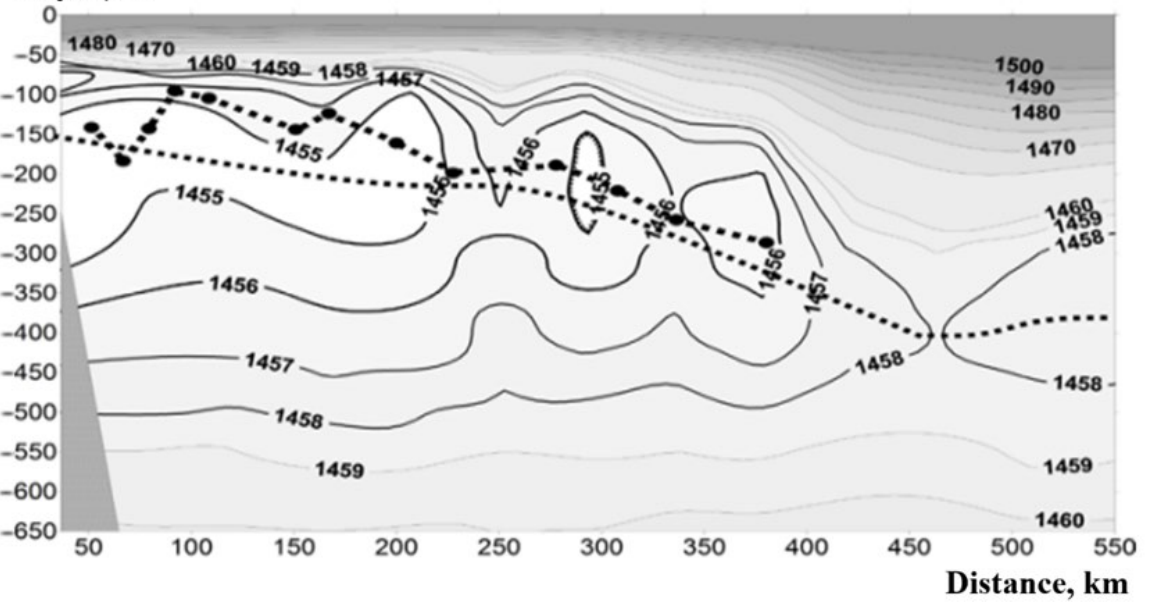
Figure 11. The average long-term sound speed distribution at the acoustic track Cape Gamova–Kita- Yamato bank.